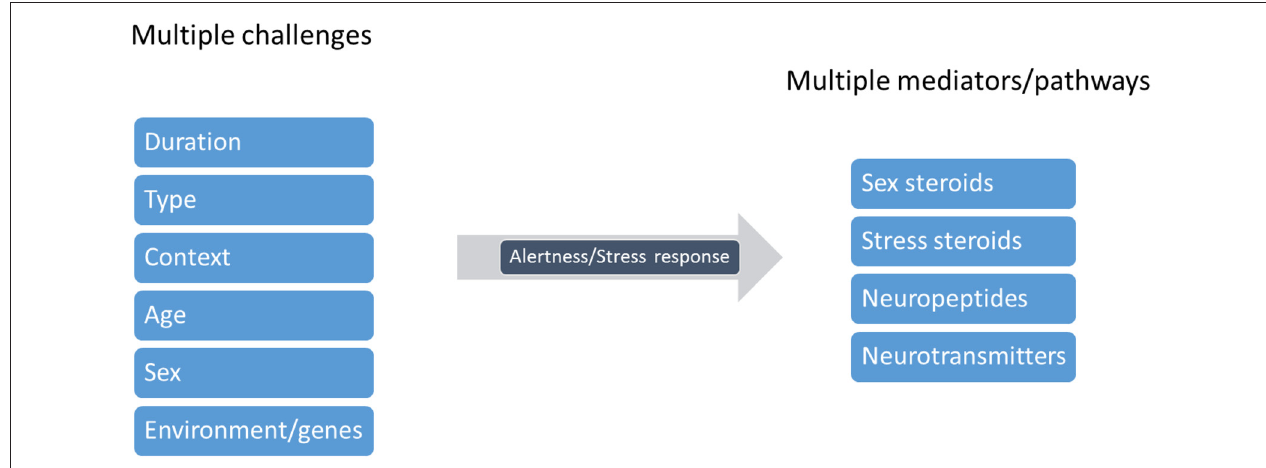
FIGURE 5 | Cleaning behavior warrants a neuro-symphony of modulators. Cleaners are subject to several challenges that will modulate the state of alertness or rather, cleaners’ stress response. These factors include the duration (pontual vs. chronic), type (heterospecific or conspecific), context (for instance, client threatens to leave), age (the developmental stage of the cleaner), cleaner sex and its genetic or environmental background. Various substances may thus be released in response to each challenge, and may influence distinct neural pathways, acting alone or combined, affecting cleaners’ decision making (figure adapted from Joëls and Baram,